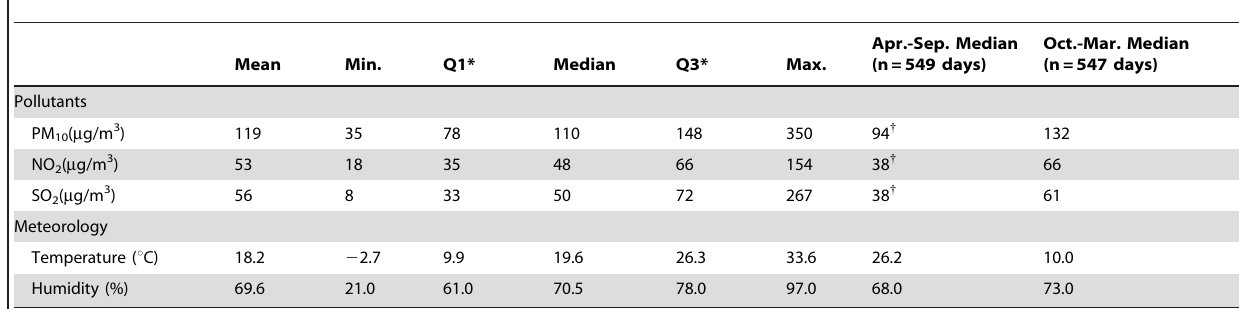
Table 1. Ambient air pollution concentrations and meteorological parameters in Wuhan, 2006–2008.